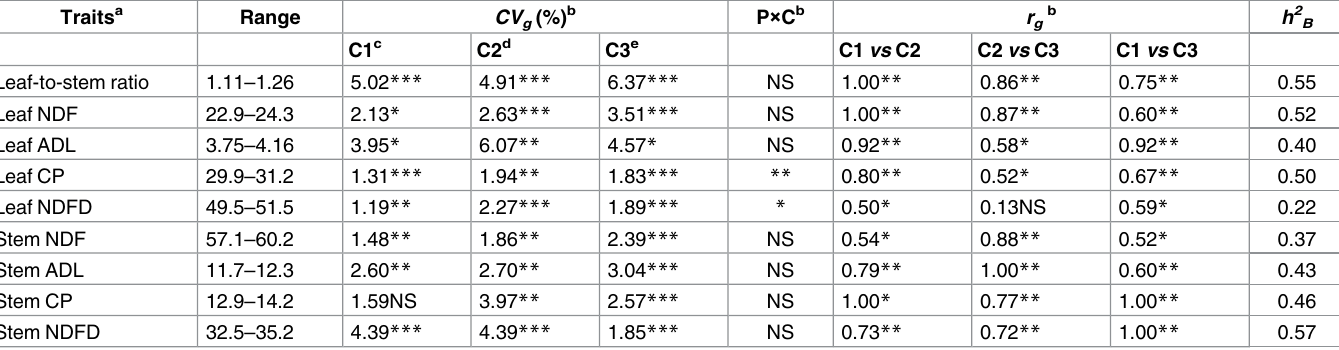
Table 2. Range of progeny mean values, genetic coefficient of variation ( CV g ) in three growing conditions (C1, C2, C3), F test results for overall progeny × condition (P × C) interaction, genetic correlation for progeny responses across pairs of conditions, and broad-sense heritability on a mean progeny basis over conditions ( h 2 B ), for forage quality traits recorded on dry leavesand stems of 154 alfalfa half-sib